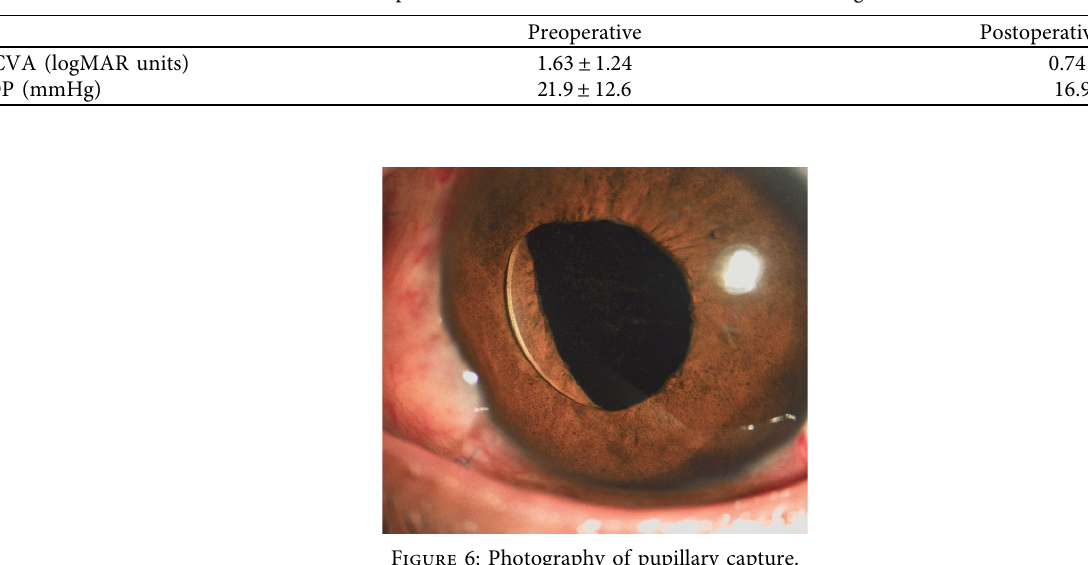
Table 3: Comparison of BCVA and IOP before and after management.